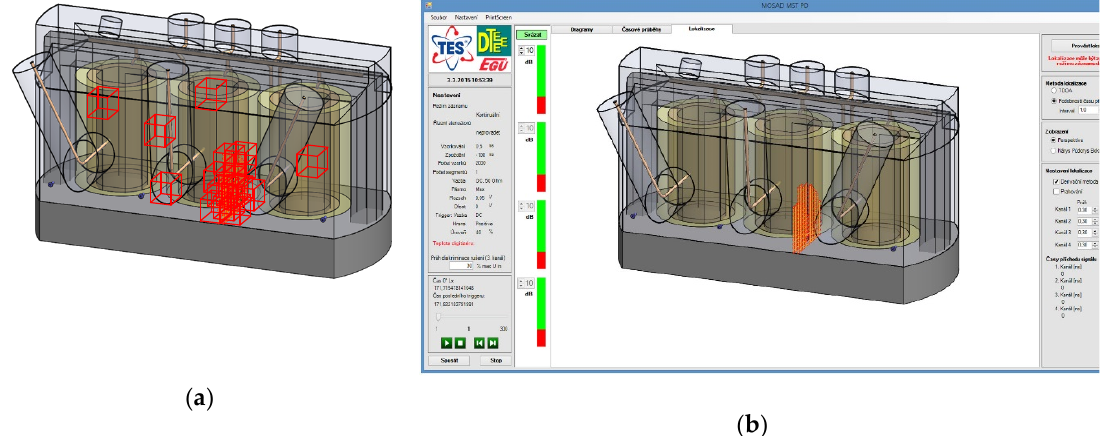
Figure 13. The principle of the comparative method ( a ) and a localization result ( b ).